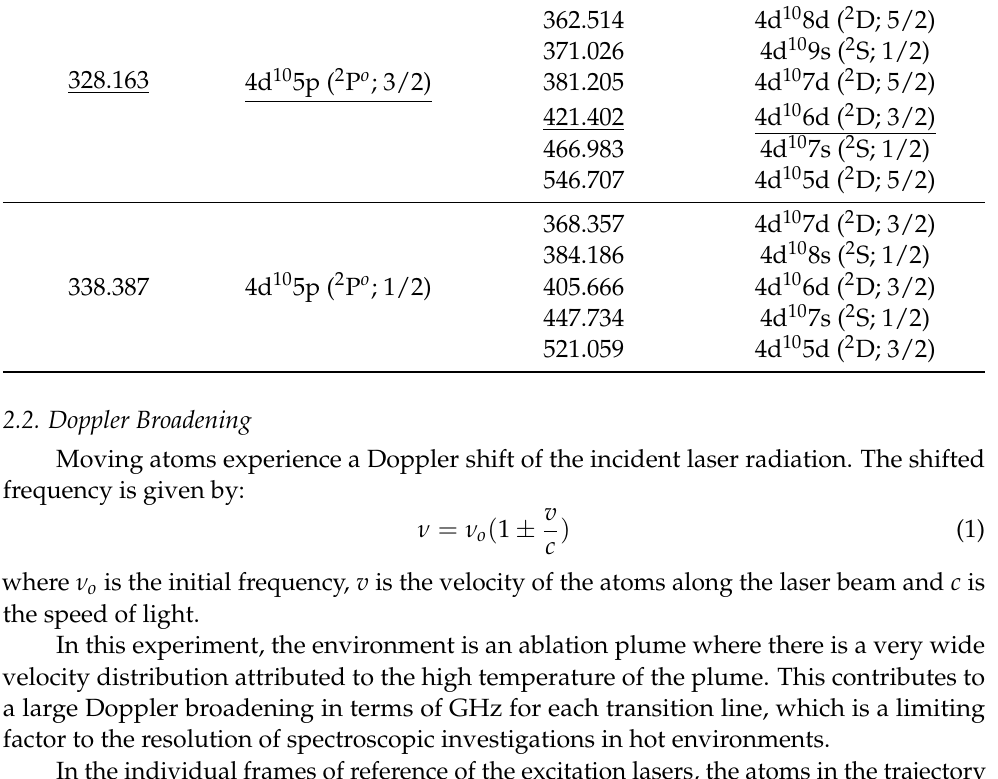
The scheme chosen for this study is the scheme underlined in Table 1: 4d 10 5s 2 S 1/2 →